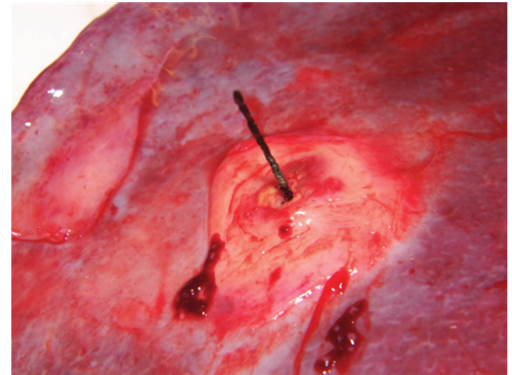
Figure 8: Postmortem image revealing a thin black 6 cm wire pen- etrating the diaphragmatic surface of the left lobe of the